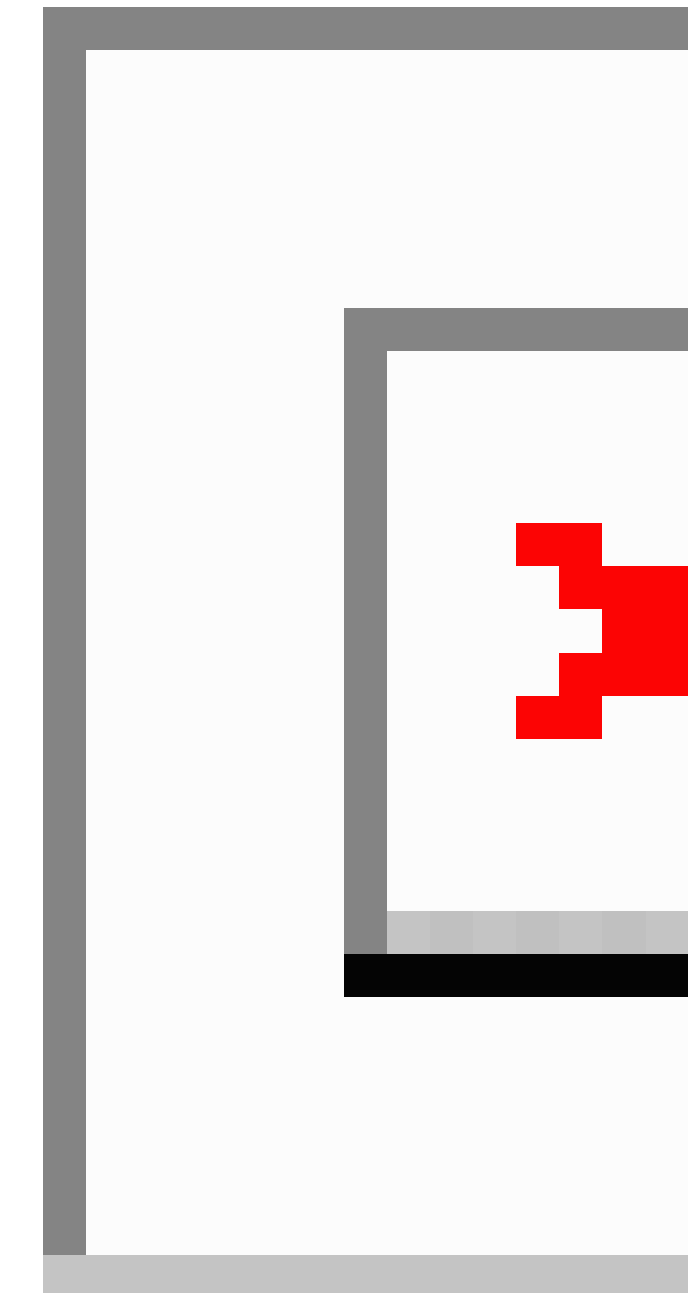
Figure 3. Likeability and learning ratings for Tumblr posted